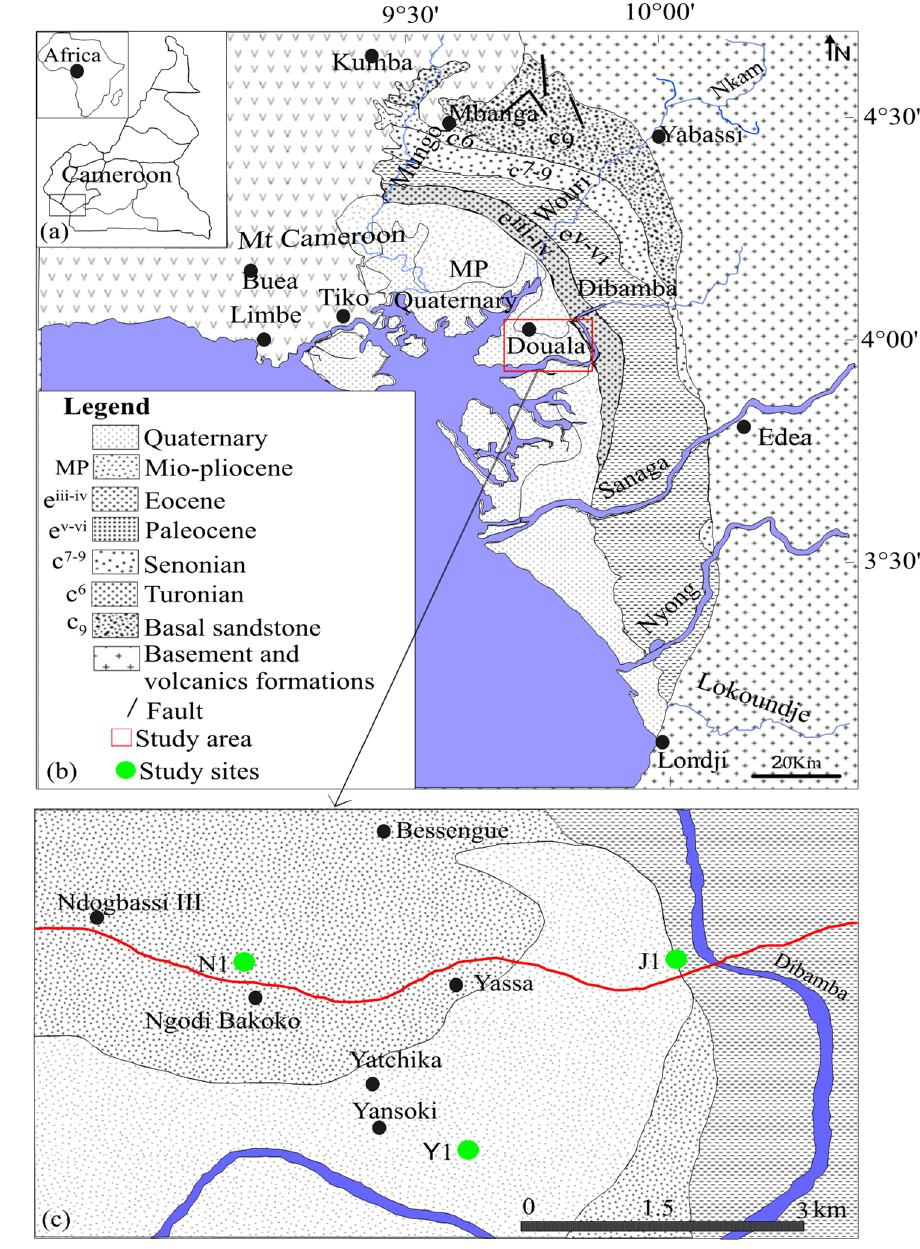
Figure 1. Geological representation of Douala modified [30]: ( a ) geolocation map of the Douala sub-basin, Littoral Cameroon; ( b ) geological representation of the Douala sub-basin containing the different study sites; ( c ) geological representation of the study area.